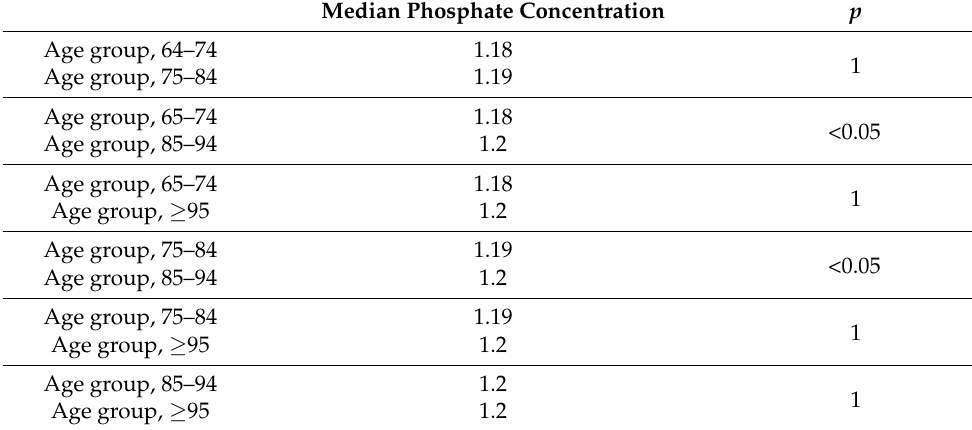
Table 4. Comparison of the median phosphate concentration between the age groups (Kruskal– Wallis